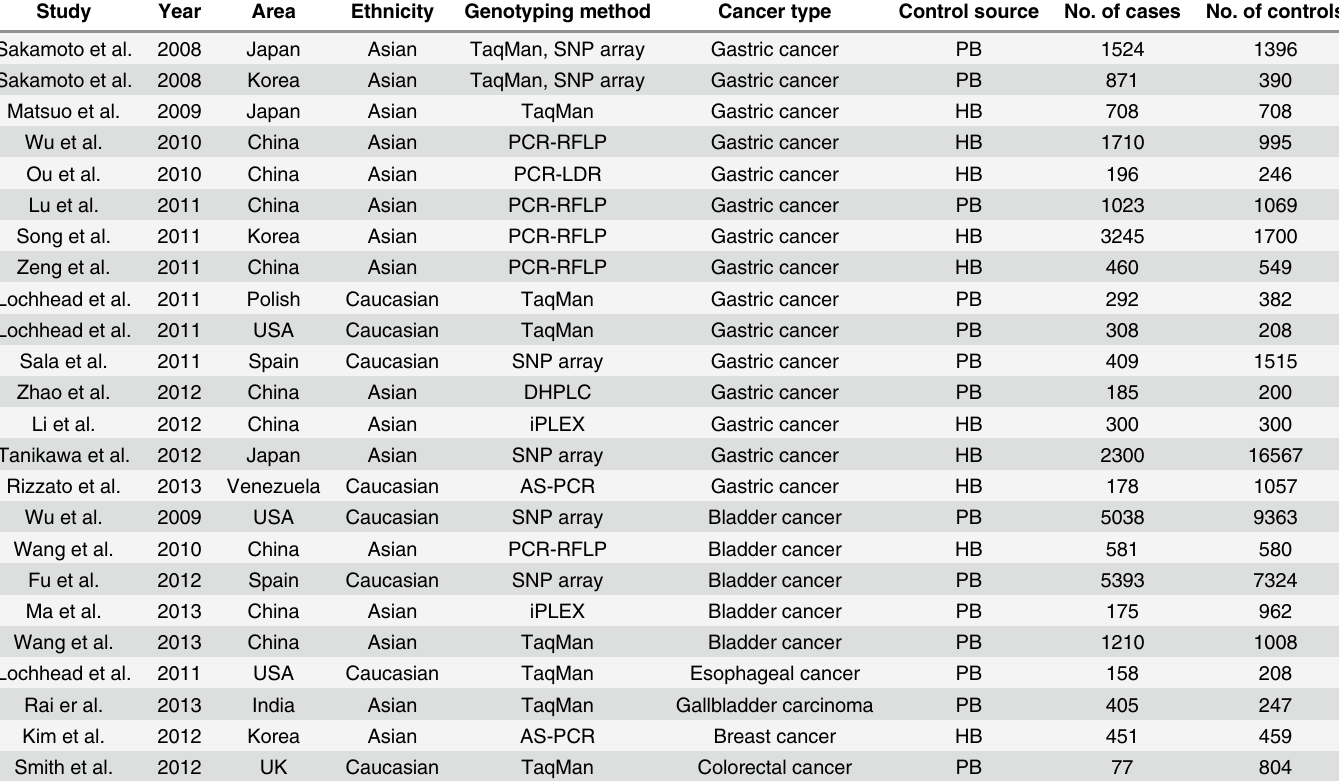
Table 1. Main characteristics of all studies included in the meta-analysis. PCR-RFLP: polymerase chain reaction-restriction fragment length polymor- phism; PCR-LDR: PCR-ligation detection reaction; DHPLC: denaturing high performance liquid chromatography; AS-PCR: allele-specific PCR; SNP: single nucleotide polymorphism, PB: population-based studies; HB: hospital-based